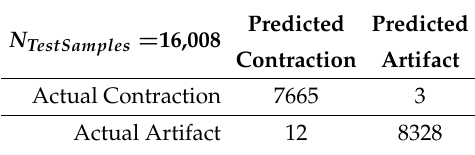
Table 11. Confusion matrix for selected RNN model (9 hidden units, 9 input features).